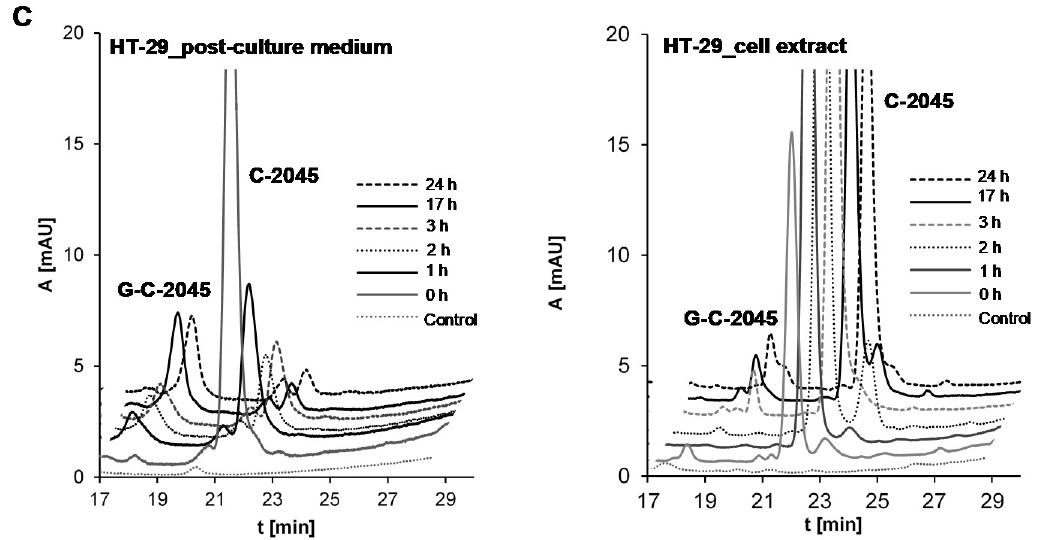
Figure 9. Glucuronidation of C-2045 in ( A ) HCT-116 cells, ( B ) HCT-116-UGT1A10 cells and ( C ) HT-29 cells. Compound concentrations on the plate were: 50 µM, 50 µM and 25 µM, respectively. The results of HPLC analyses of post-culture media and cell extracts are presented as a set of chromatograms: Control (control of medium/cell extract from cells not treated with the compound) and after desired incubation times. Analysis at 430 nm by RP-HPLC (Shimadzu) and ESI-MS.